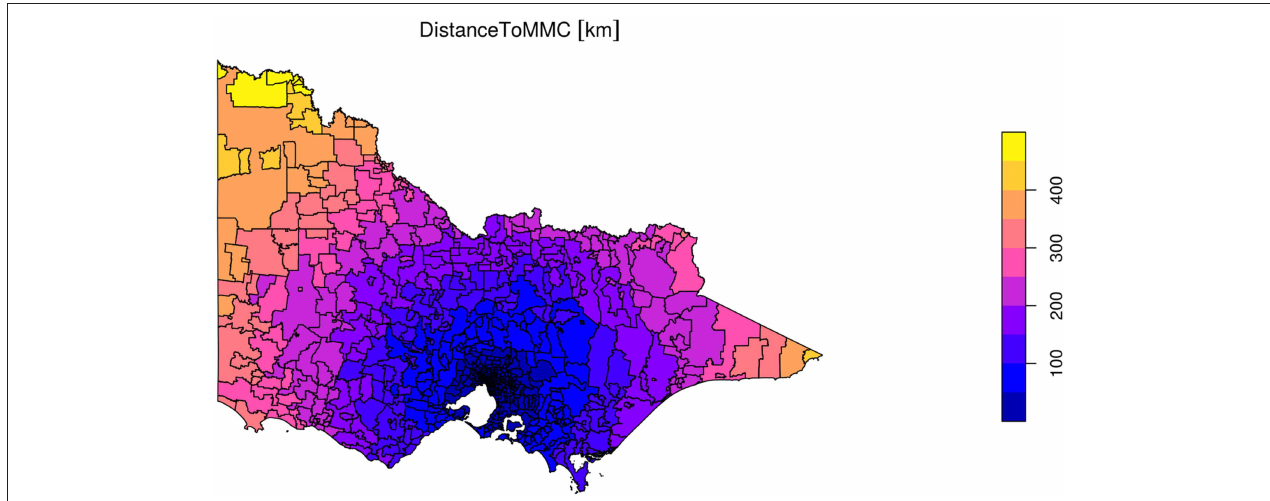
FIGURE 1 | Visualization of straightline distance calculation from every postcode in the state to Monash Medical Centre. Static visualization created with tmap .